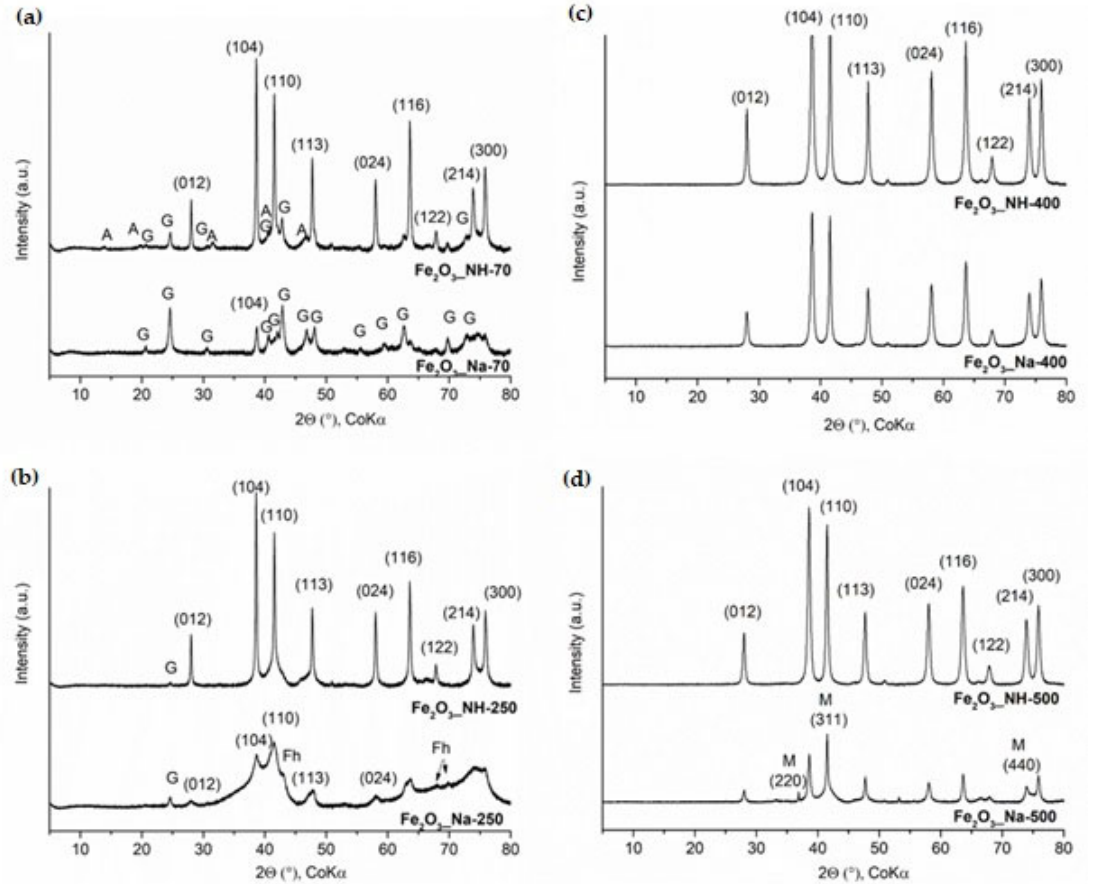
Figure 1. XRD patterns of the hematite samples prepared using two precipitated systems at: ( a ) 70 °C, ( b ) 250 °C, ( c ) 400 °C, ( d ) 500 °C; peaks of hematite are assigned with indices (hkl), G = goethite, A = akageneite, Fh = ferrihydrite, M = magnetite.